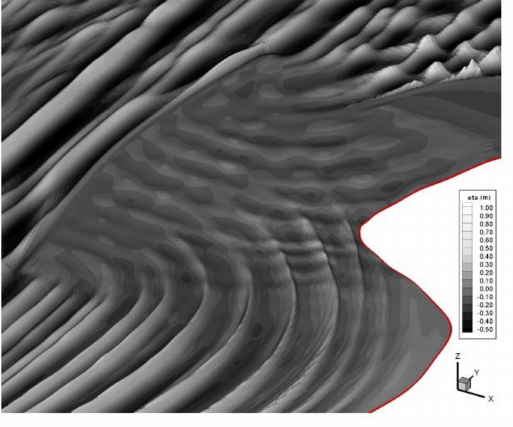
Figure 6. The instantaneous wave field. Present sea bottom level. Configuration